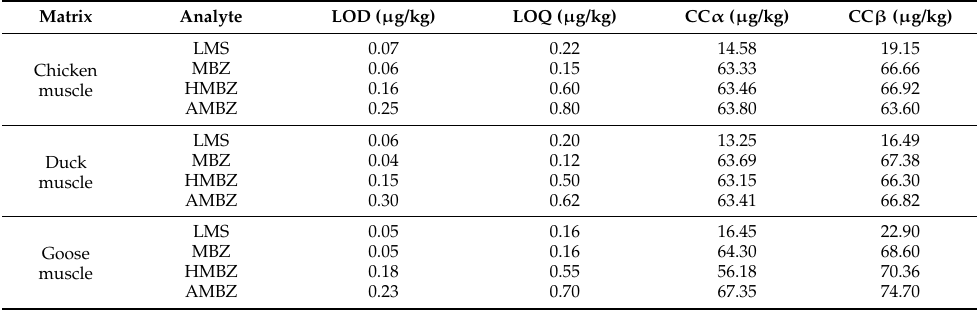
Table 5. LOD, LOQ, CC α and CC β of LMS, MBZ, HMBZ and AMBZ in poultry muscle.